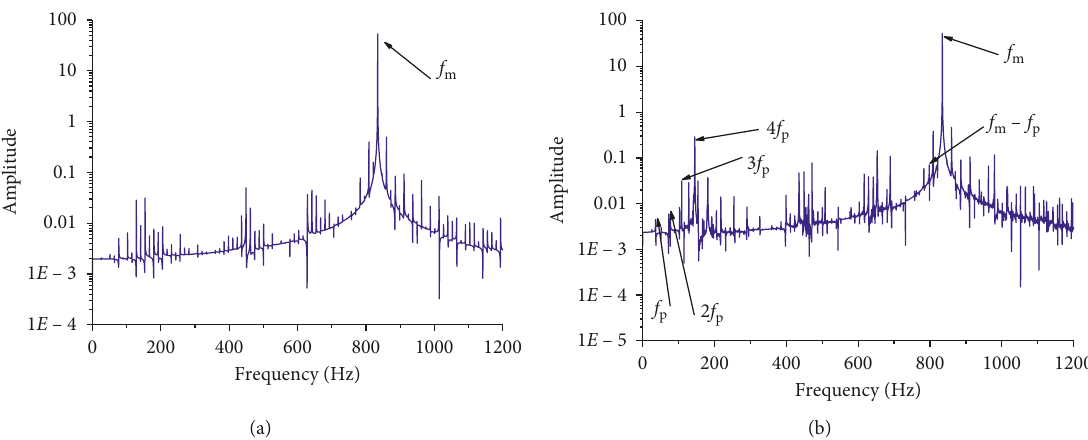
Figure 14: Frequency spectrum diagram of vertical vibration acceleration of wheelset (frequency range: 0–1200): (a) health gear (b) the crack length of the pinion is 4mm.